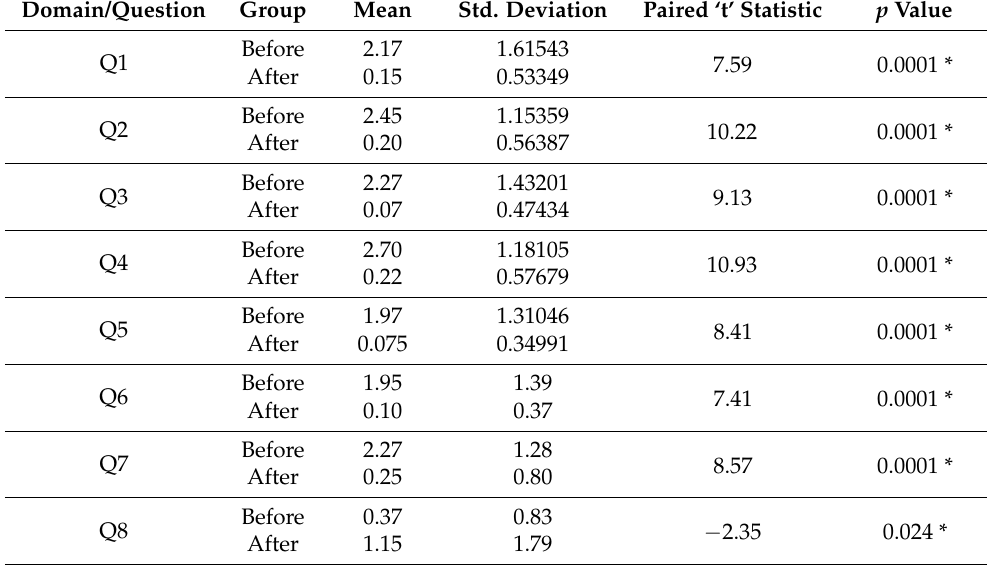
Table 5. Comparative evaluation of quality of life before and after treatment in Group 3— Reciprocating Technique.